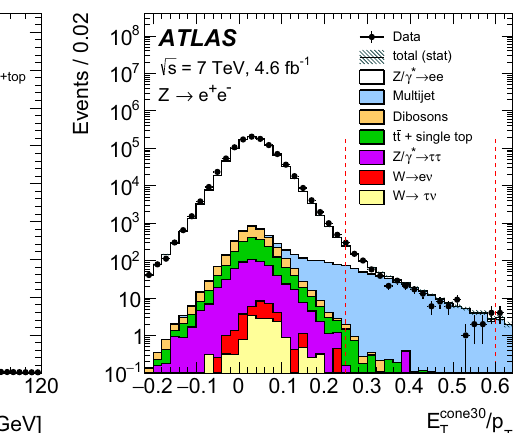
E0.2 /p cone30 T T / p Fig. 1 Distributions used for the estimation of the multijet background In the Z → e + e − channel, the region of large isolation E cone30 T , T in the W + → e + ν channel ( left ) and Z → e + e − channel ( right ). For betweenthe twoverticallines ,isusedtonormalizethemultijettemplate from data. The shown distribution is taken from the central Z → e + e − the W + → e + ν channel, the result of the template fit in a multijet- enhanced region using the E miss distribution is shown. The vertical line analysis in the region 66 < m ee < 116 GeV. The sum of all expected T = 60 GeV) of the region used in background and signal contributions is shown as a solid line with a indicates the upper boundary ( E miss T hashed band detailing the statistical uncertainty and labelled “total the fit. The label “EWK+top” refers to the electroweak and top-quark background contributions estimated from MC simulation, which are here treated in a common template together with the W → e ν signal.